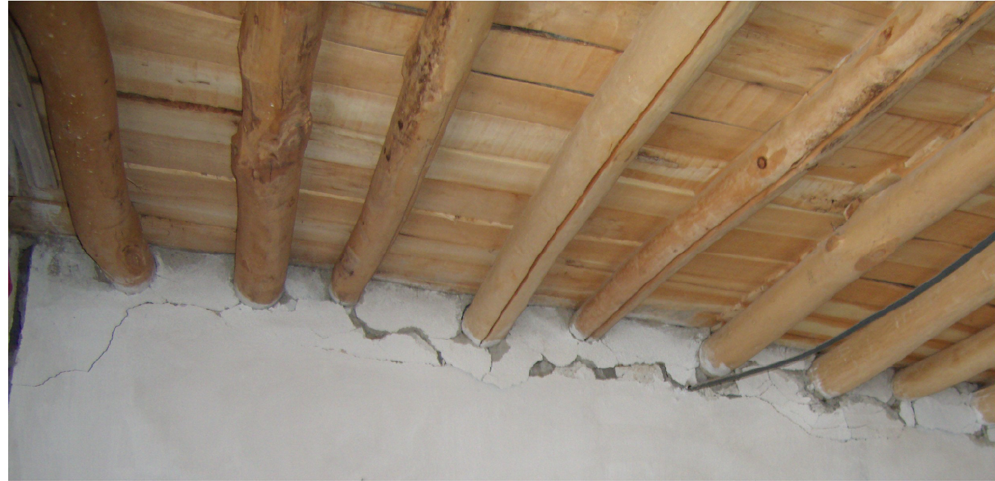
Fig. 18. The plaster spalling under the log ends and longitudinal cracks in some